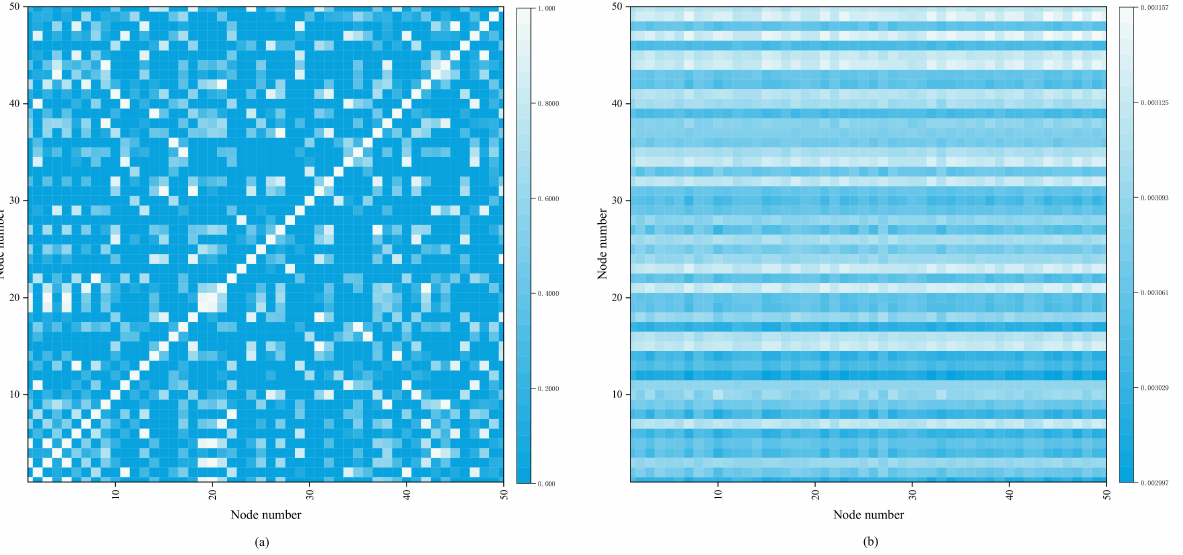
Figure 8. Adjacency matrix for the top 50 nodes of the PEMS-BAY dataset. ( a ) is the visualization of the adjacency matrix calculated from the distances between nodes in the real road network; ( b ) is the visualization of adjacency matrix derived from the location-based learnable attention